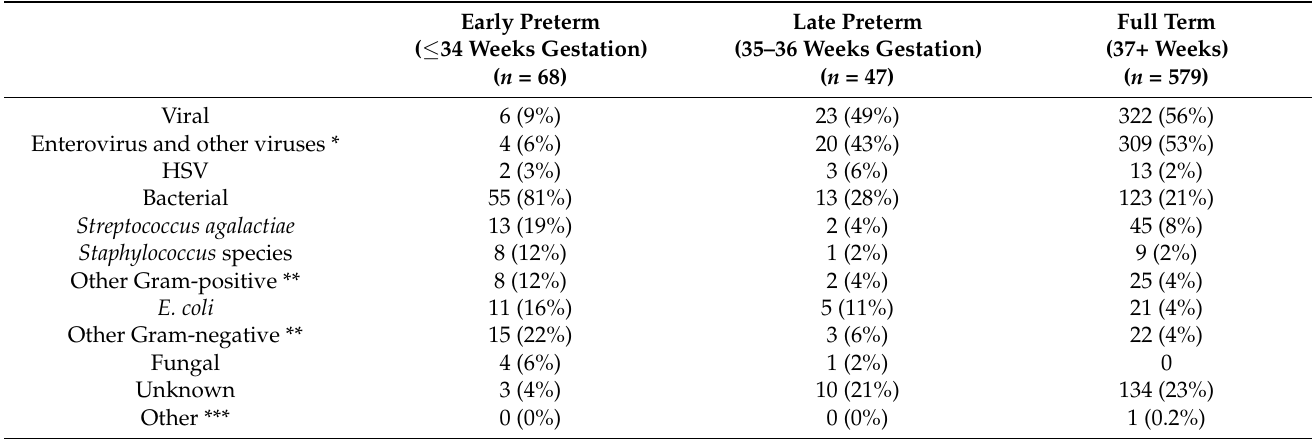
Figure 3. Bacterial meningitis and resistance patterns by year. Table 5. Distribution of causes of meningitis by gestational age at